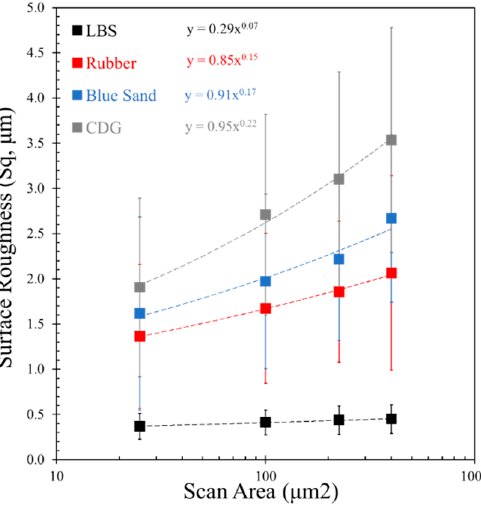
Figure 3. 2D surface profiles with scanned area of 66.4 × 88.7 µ m of ( a ) LBS, ( b ) blue sand, ( c ) CDG, and ( d ) rubber.